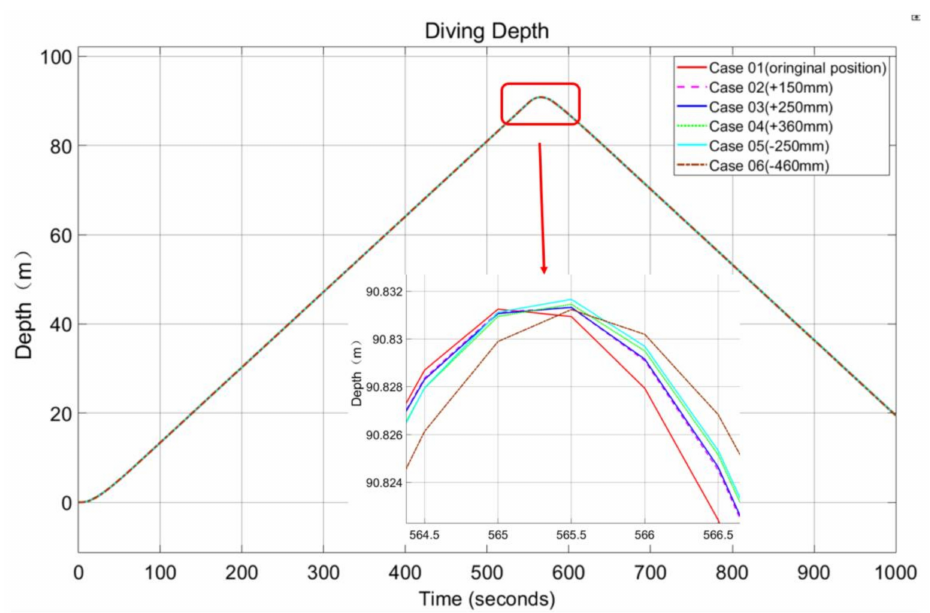
Figure 17. Gliding depth with same gliding